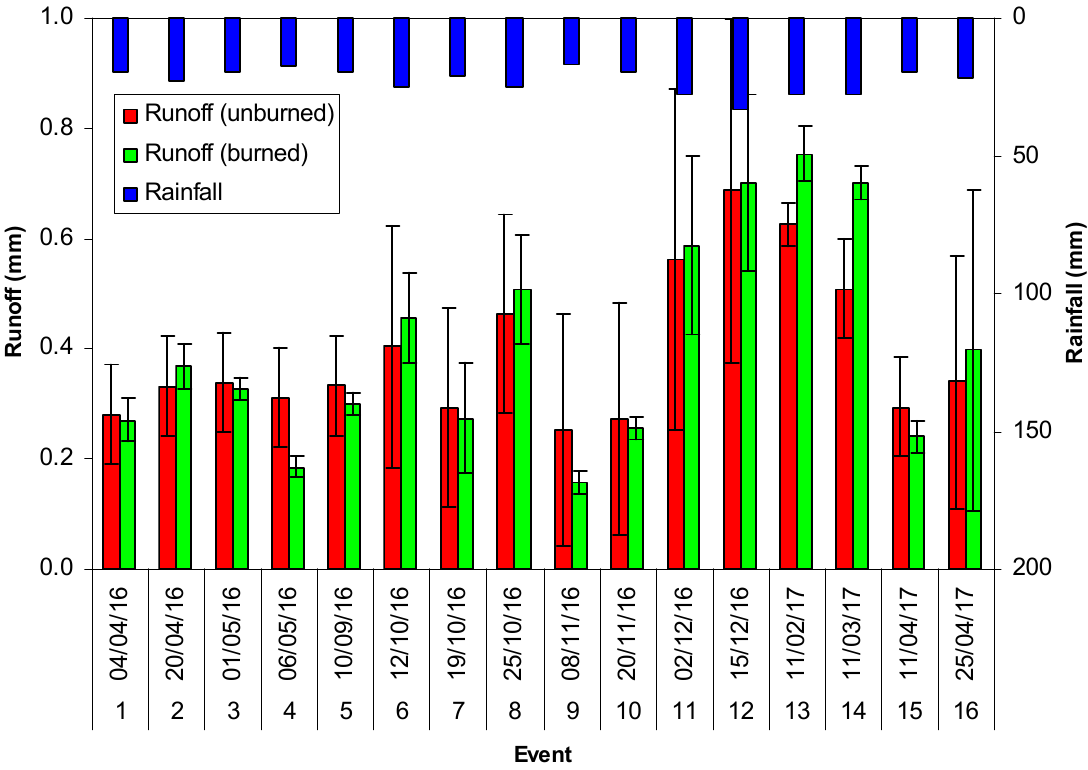
Figure 3. Rainfall and runoff volumes observed in forest plots subject to wildfire (Liétor, Castilla La Mancha, Spain). Vertical bars are the standard deviations.